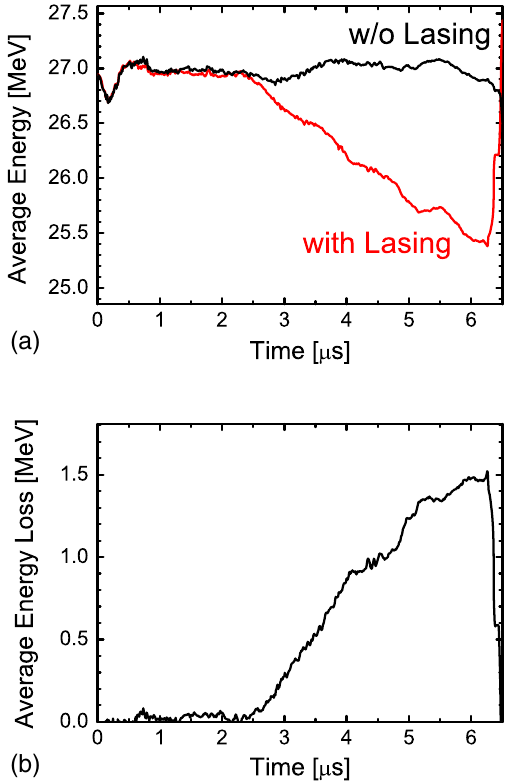
FIG. 6. Measured evolution of the energy distribution of the electron beam with and without FEL lasing for a DCD parameter of 9 . 4 μ m. (a) without FEL lasing. (b) with FEL lasing.